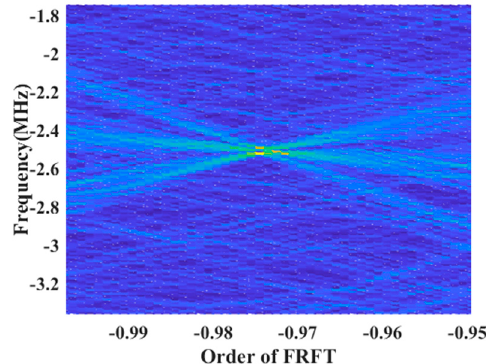
Figure 6. Time-frequency result of echo radar. Figure 6 is a U-axis slice of the result of FRFT transformation of the PSh-covered tar- get. It is known that during the FRFT transformation, the angle axis only affects the esti- (U axis), and obtaining the echo signal carrier frequency projection on the U axis. Through